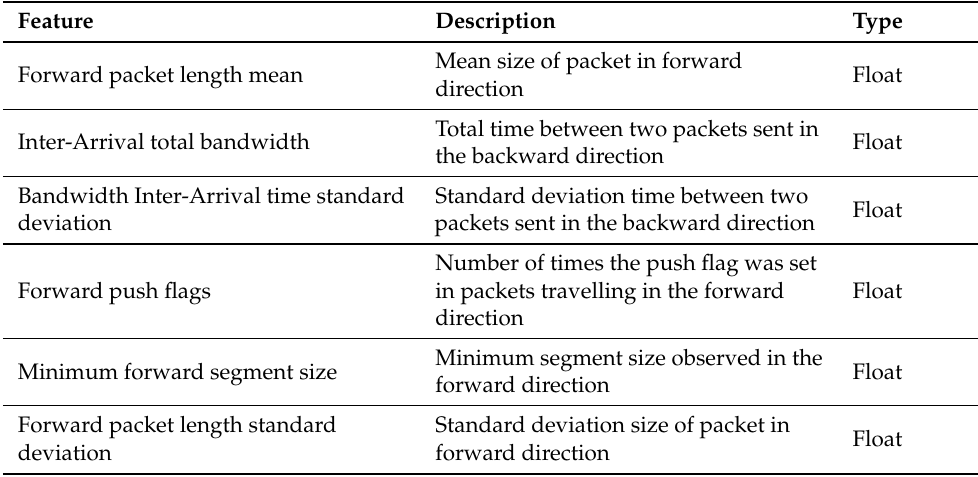
Table 5. Features selected & extracted using the PCA